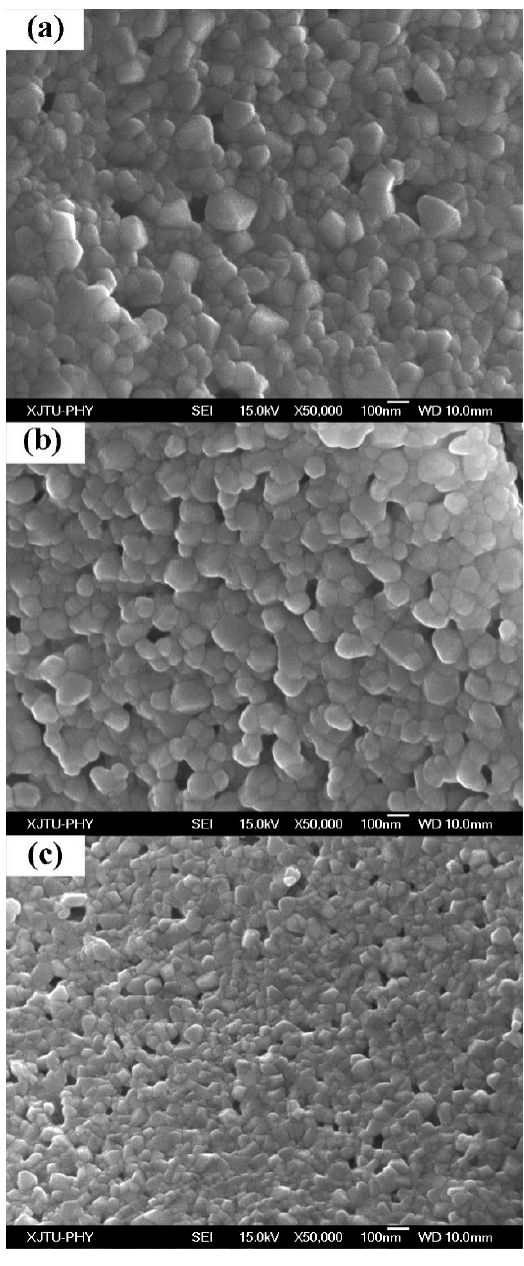
Figure 4. Scanning electron microscopy (SEM) images of Gd 2 O 3 and Y 2 O 3 doped ZrO 2 powders: ( a ) 0 mol% Gd 2 O 3 and 4 mol% Y 2 O 3 doped ZrO 2 ; ( b ) 2 mol% Gd 2 O 3 and 2.5 mol% Y 2 O 3 doped ZrO 2 ; and ( c ) 4 mol% Gd 2 O 3 and 0 mol% Y 2 O 3 doped ZrO 2 .